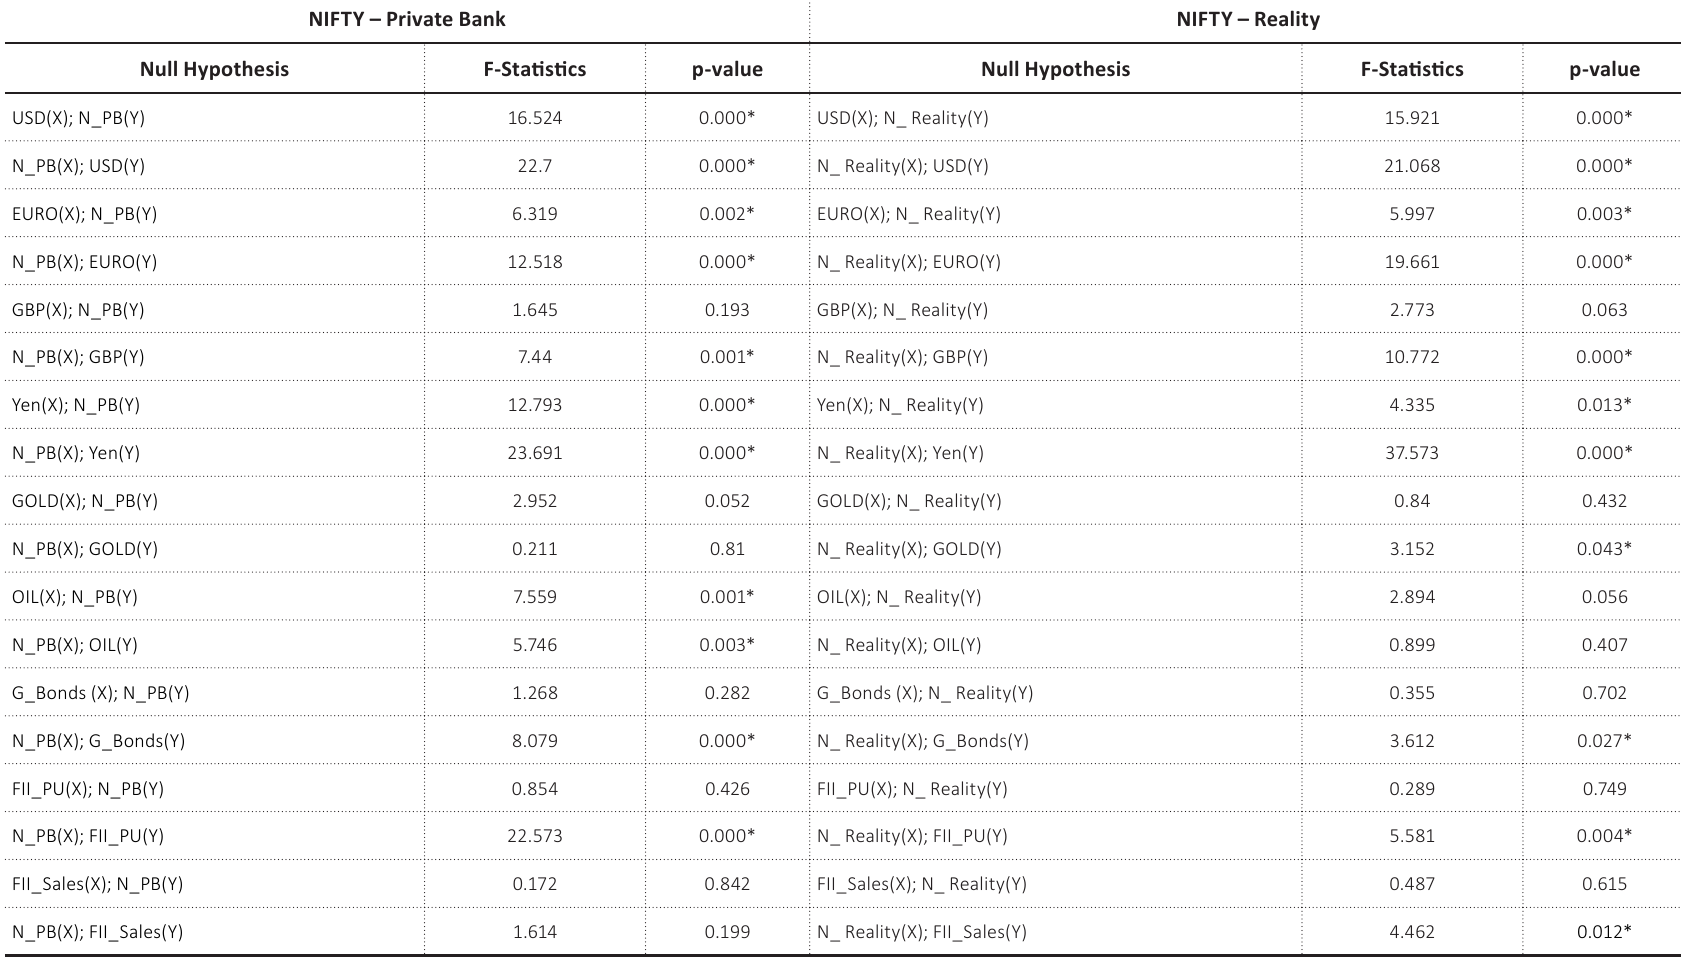
Table A4. Granger causality test results of NIFTY – Private banks and Reality